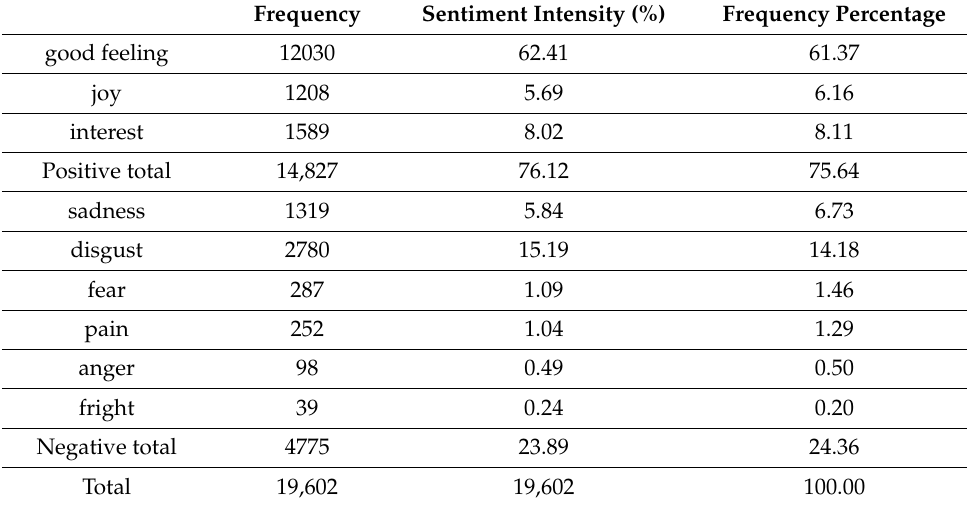
Table 10. Sentiment analysis of food delivery (2019).